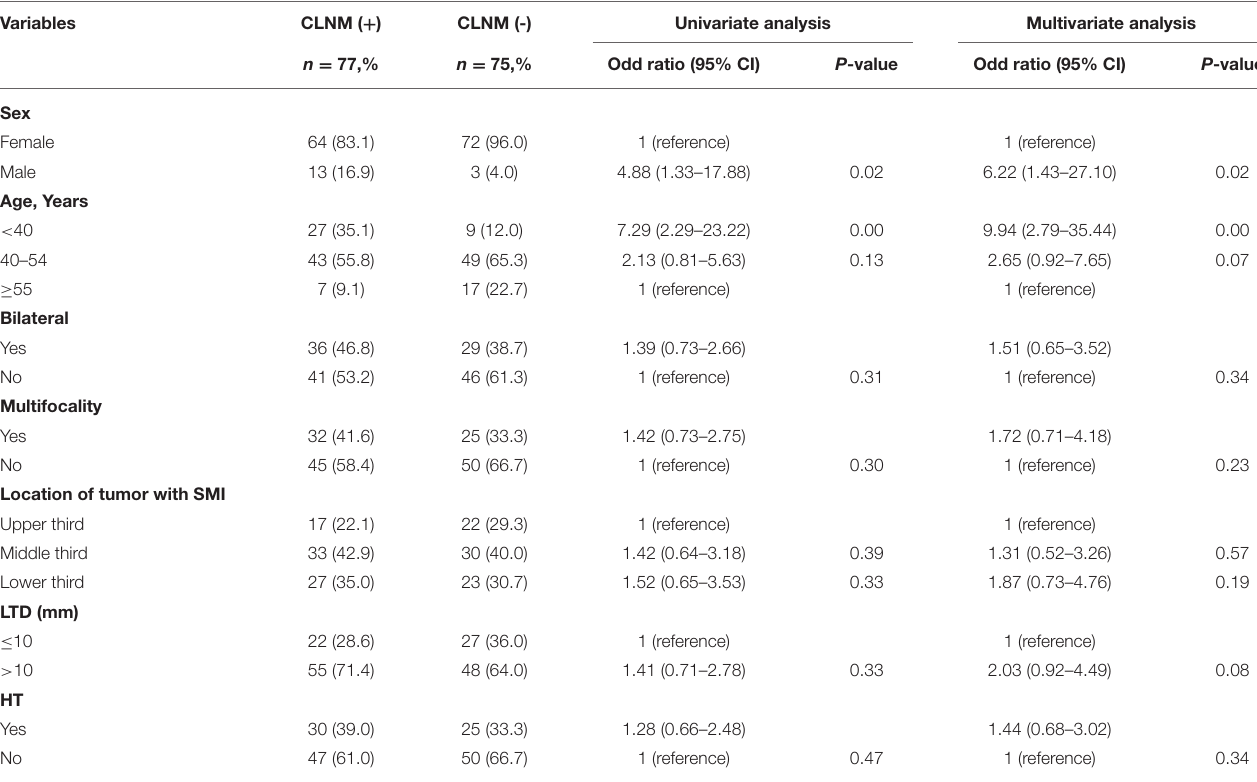
TABLE 2 | Univariate and multivariate analysis of clinicopathological characteristics for CLNM in cN0 PTCs with SMI. Variables CLNM (-) Univariate analysis Multivariate analysis